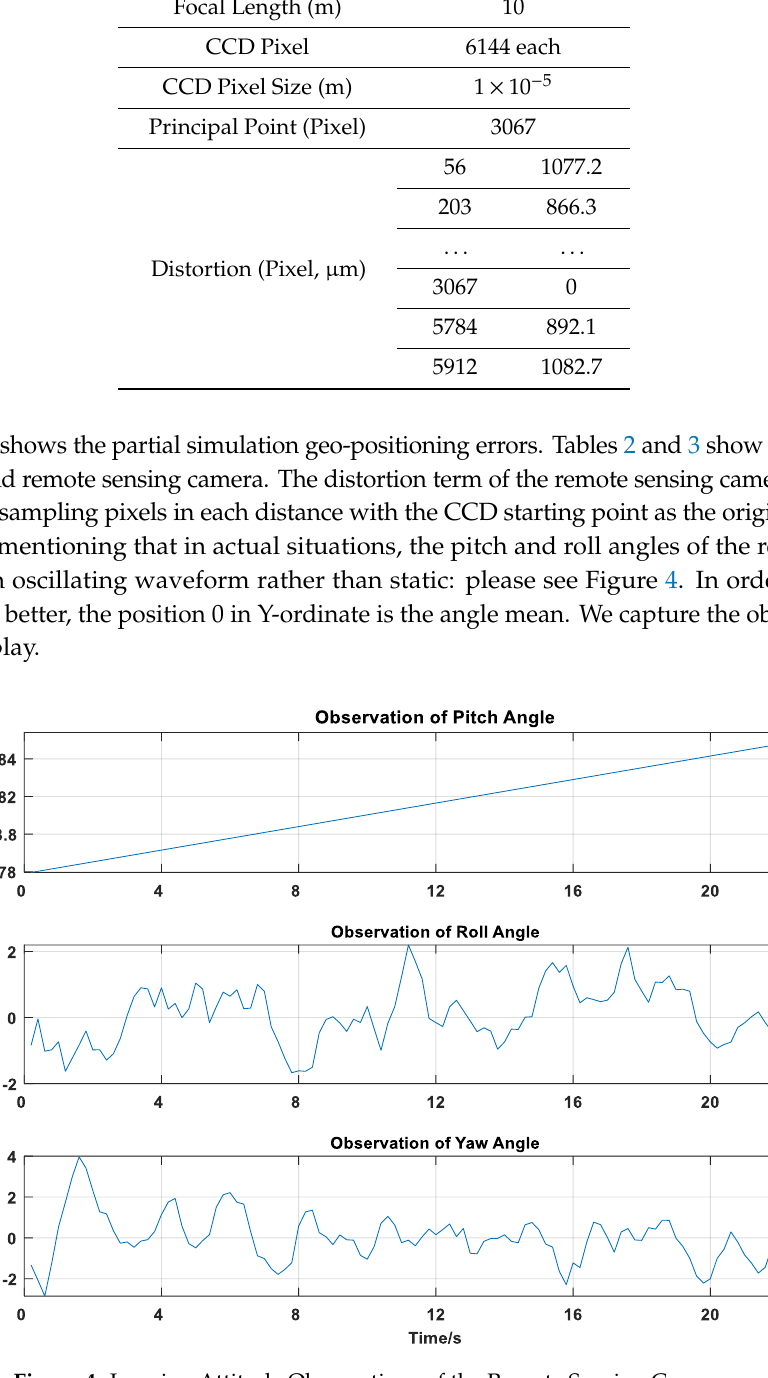
Table 3. Remote Sensing Camera Parameters.